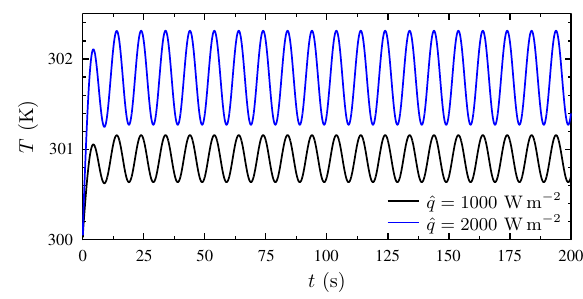
Fig. 10. Time dependency of the surface temperature at a dis- tance of 100 mm from the beginning of the measuring section for two cases of heat flux amplitudes ˆ q and the heat transfer co- e ffi cient between the pipe surface and surroundings 3 Wm − 2 K − 1